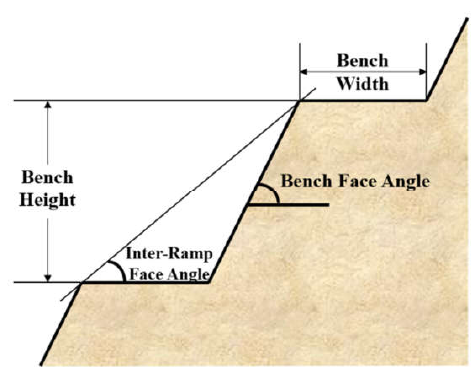
Figure 4. Bench geometries used in bench design.